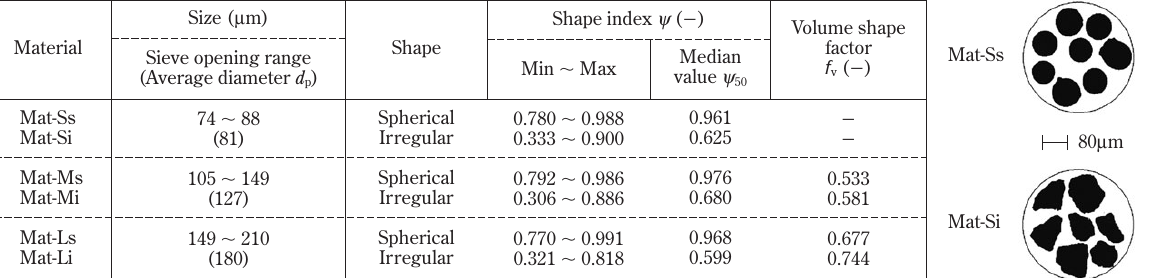
Table 1 Experimental materials used (mullite particles: density ρ p (cid:4) 2,920kg/m 3 )